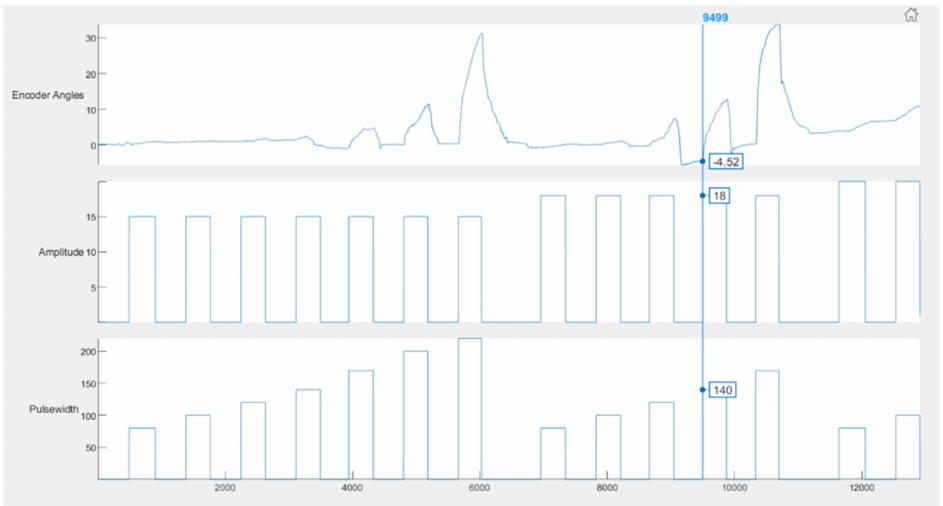
Figure 11. Example of error during calibration. The vertical line passing through the graph shows that at 18 mA and 140 µ s, the baseline value was − 4.52 instead of 0, which is one possible source of